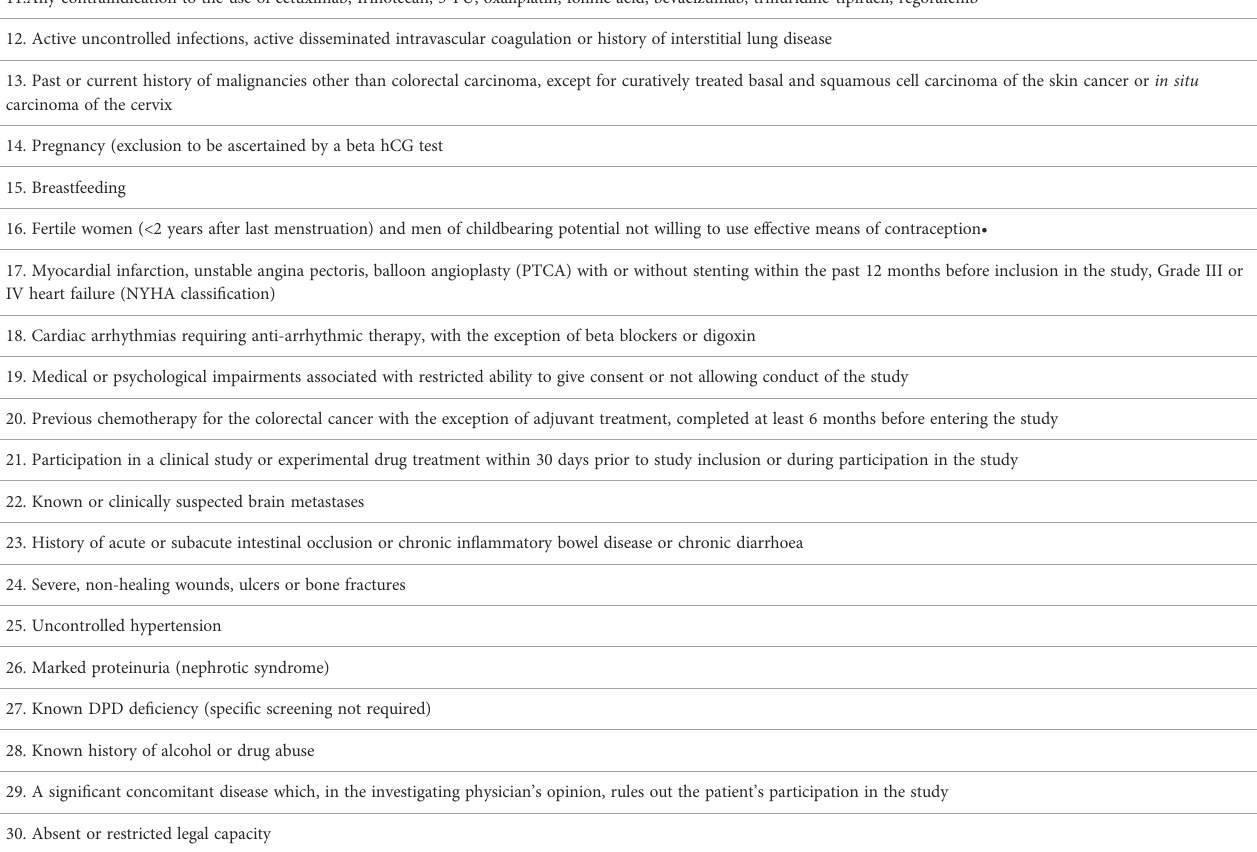
TABLE 2 Patients eligible for this study must not meet any of the following criteria at the start of fi rst line